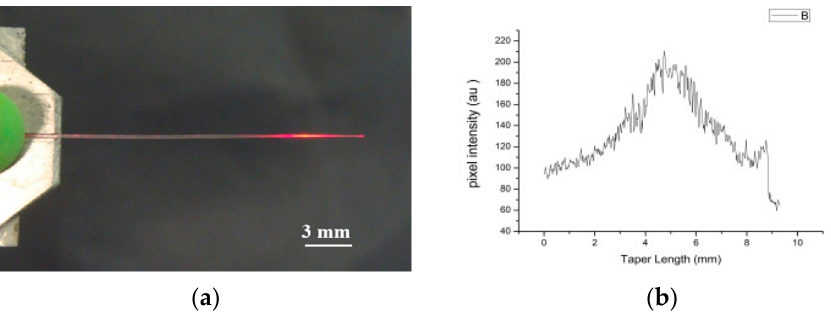
Figure 4. ( a ) Side view (perpendicularly to the taper axis) of illuminated taper, ( b ) Side intensity distribution.